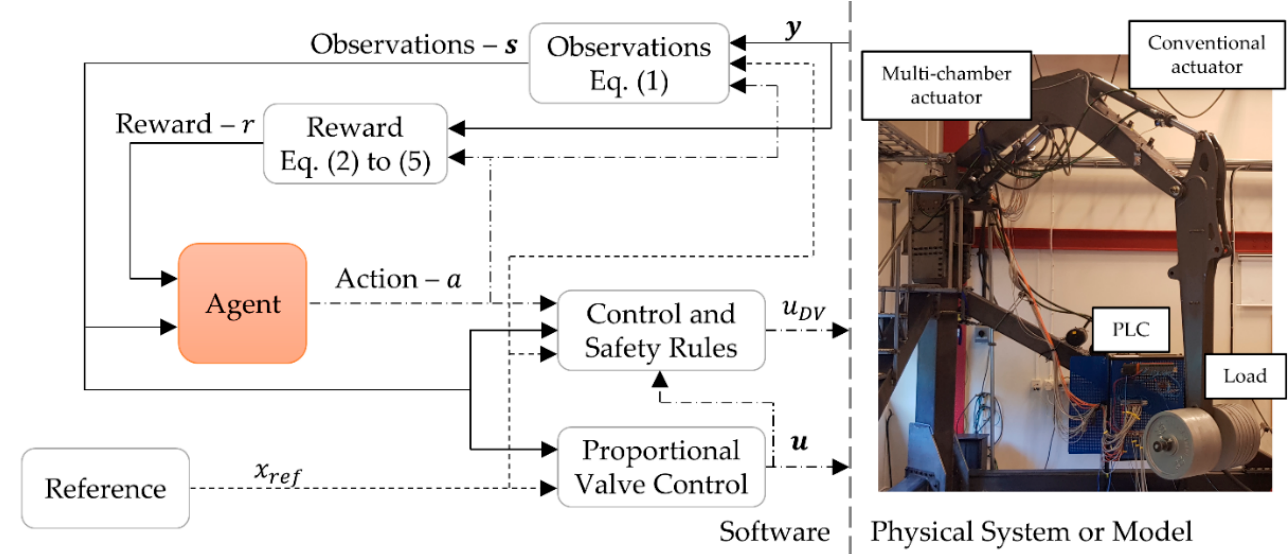
Figure 3. Structure of the controller and picture of the test bench.